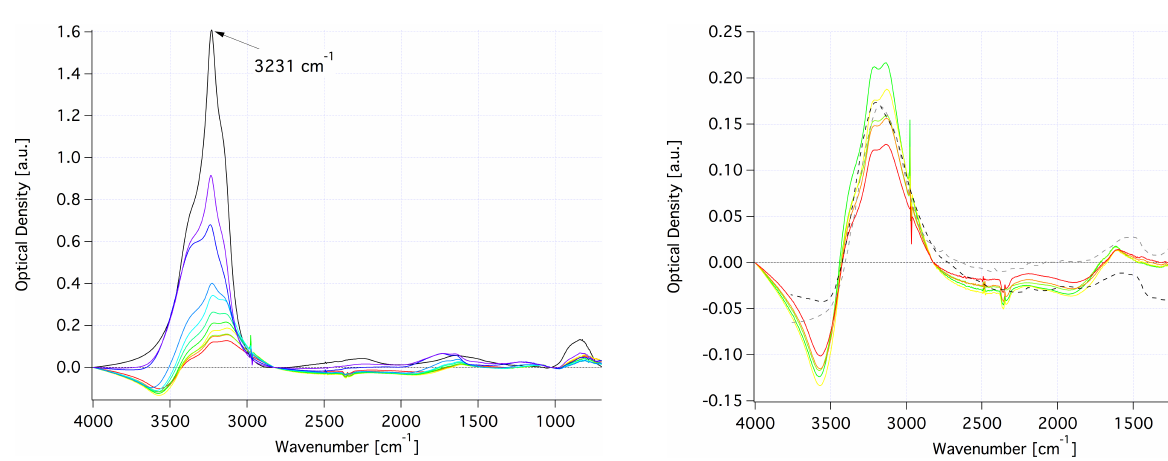
Figure 12: Comparison of FTIR spectra of amHCl films. Our experimentally 1269 Figure 12. Comparison of FTIR spectra of amHCl films. Our exper- imentally measured spectra are shown in colours according to tem- measured spectra are shown in colours according to temperature, whereas the dashed 1270 perature, whereas the dashed spectra correspond to samples made spectra correspond to samples made by condensing HCl:H 2 O gaseous mixtures of 1271 by condensing HCl/H 2 O gaseous mixtures of ratios 1 : 200 (black ratios 1:200 (black line) and 1:50 (grey line) at 190 K of Xueref and Dominé (2003). 1272 line) and 1 : 50 (grey line) at 190K of Xueref and Dominé (2003). The temperature of the ice sample ranges between 187 and 200 K with each spectrum 1273 The temperature of the ice sample ranges between 187 and 200K measured in the aftermath of the first pulse in a series of PV experiments at 1274 with each spectrum measured in the aftermath of the first pulse in a temperature intervals of roughly 3 K. 1275 series of PV experiments at temperature intervals of roughly